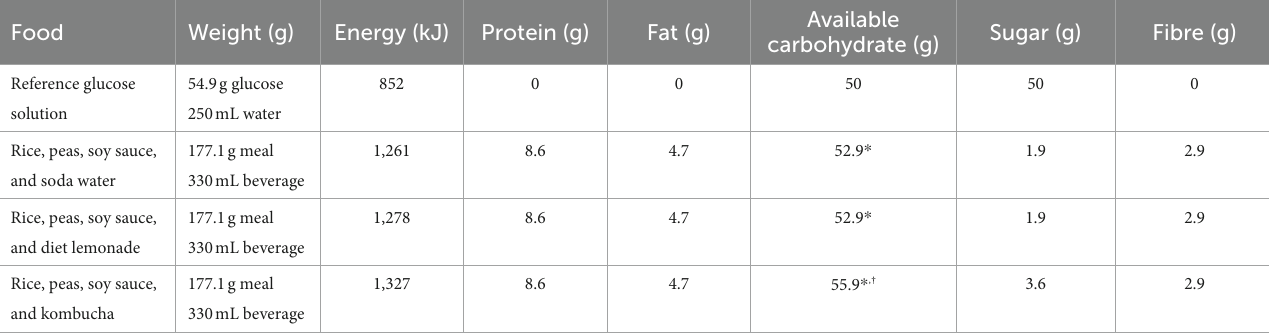
TABLE 1 Nutritional composition of the reference glucose solution and the three test meals. Food